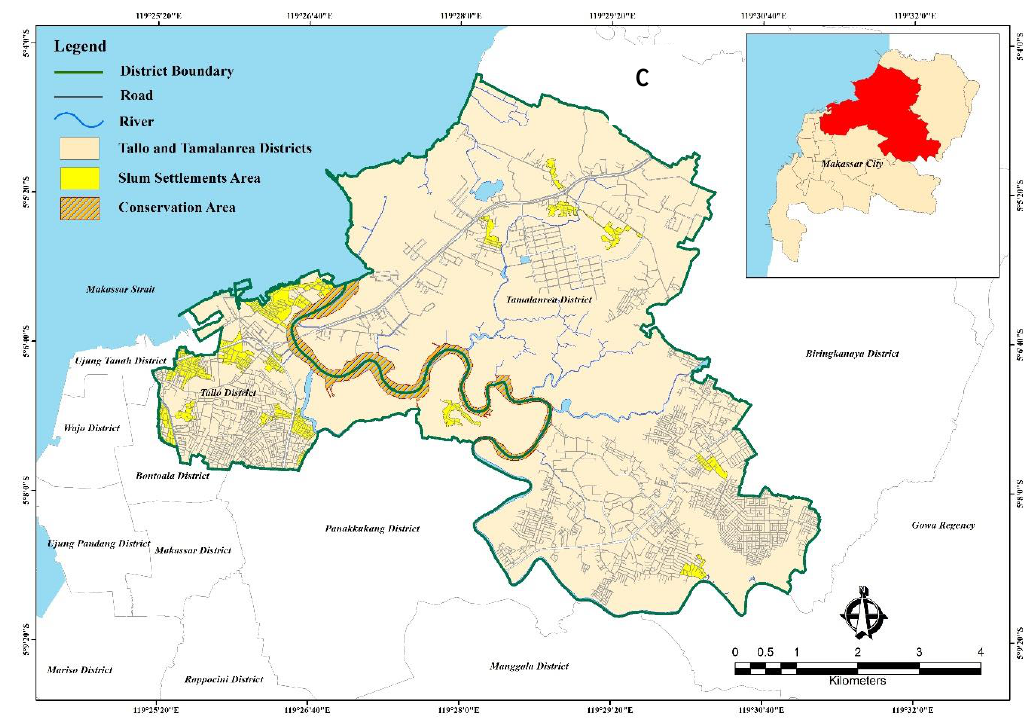
Figure 2. ( A – C ). Research Locations in Tamalanrea District and Tallo District in Makassar City. Table 1. Geographical Location and Typology of Slums Based on Kelurahan in Tamalanrea District and Tallo District in Makassar